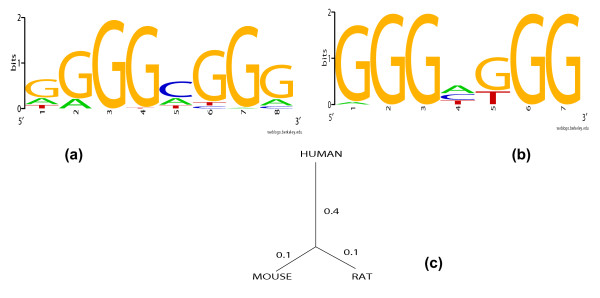
Results on the human SP1 regulon. (a) The known motif. (b) Motif reported by PhyME, using mouse and rat orthologs. (c) The phylogenetic tree used by PhyME.